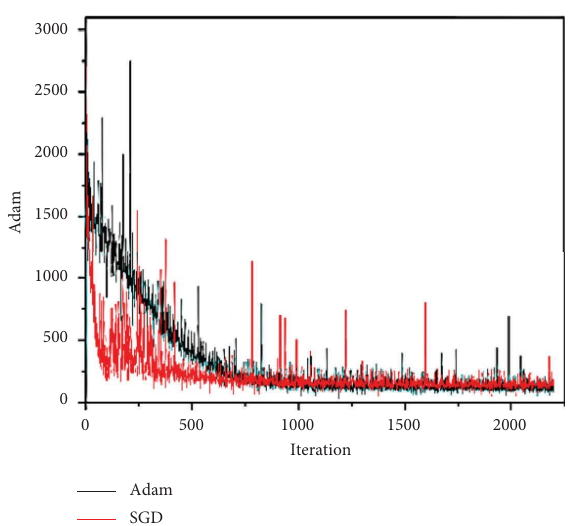
Figure 3: Te comparison of training loss curves between two